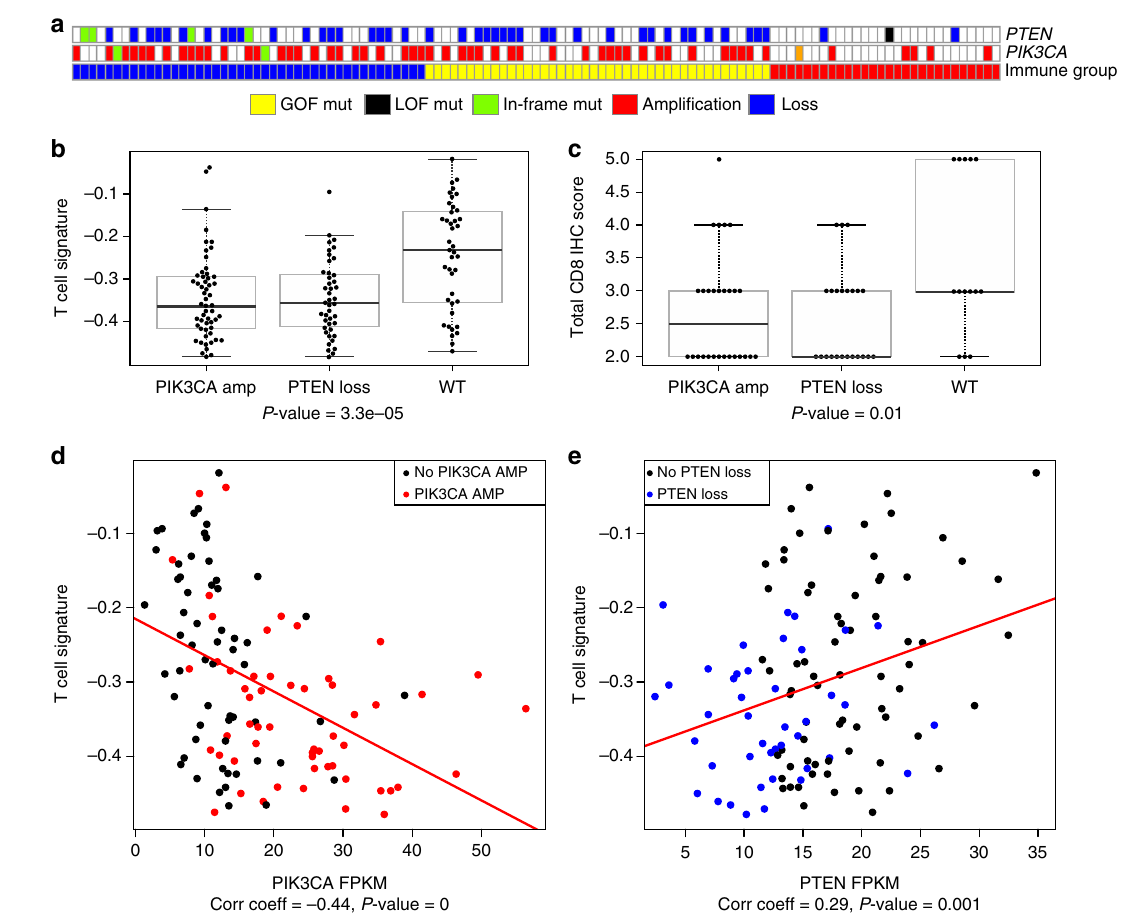
Fig. 5 PI3K pathway activation versus T cell in fi ltration. a PTEN loss and PIK3CA ampli fi cation were enriched in immune LOW and MIX group SQCC (immune group red, yellow, and blue for HIGH, MIX, and LOW). b Comparison of PTEN and PIK3CA alteration with T cell signature. c Comparison of PTEN and PIK3CA alteration with CD8 IHC H-score. d PIK3CA expression versus T cell signature, ampli fi cation/high expression (red) was associated with low T cell signature. The top and bottom of the boxes are the lower and upper quartiles. The middle line in the box is median, and the whiskers are lowest and highest point within 1.5 times the interquartile range of the lower and upper quartile. e PTEN expression versus T cell signature, loss/low expression (blue) was associated with low T cell expression. Source data are provided as a Source Data fi